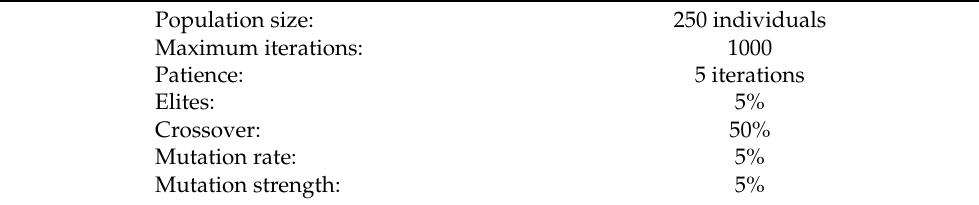
Table 5. Hyperparameters for simple GA used in this paper. Population size: